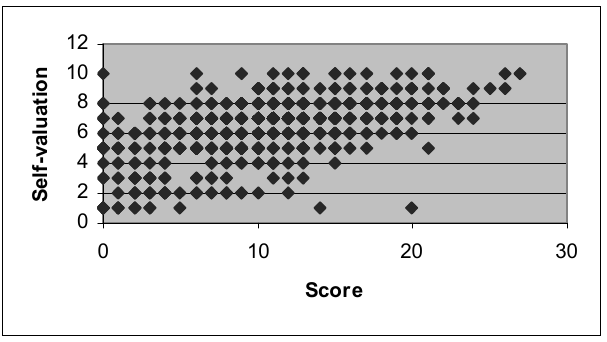
Figure 2 – Scatter-plot for self-evaluation against